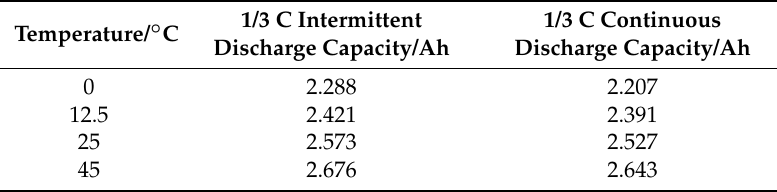
Table 1. Capacity of 1/3 C intermittent and continuous